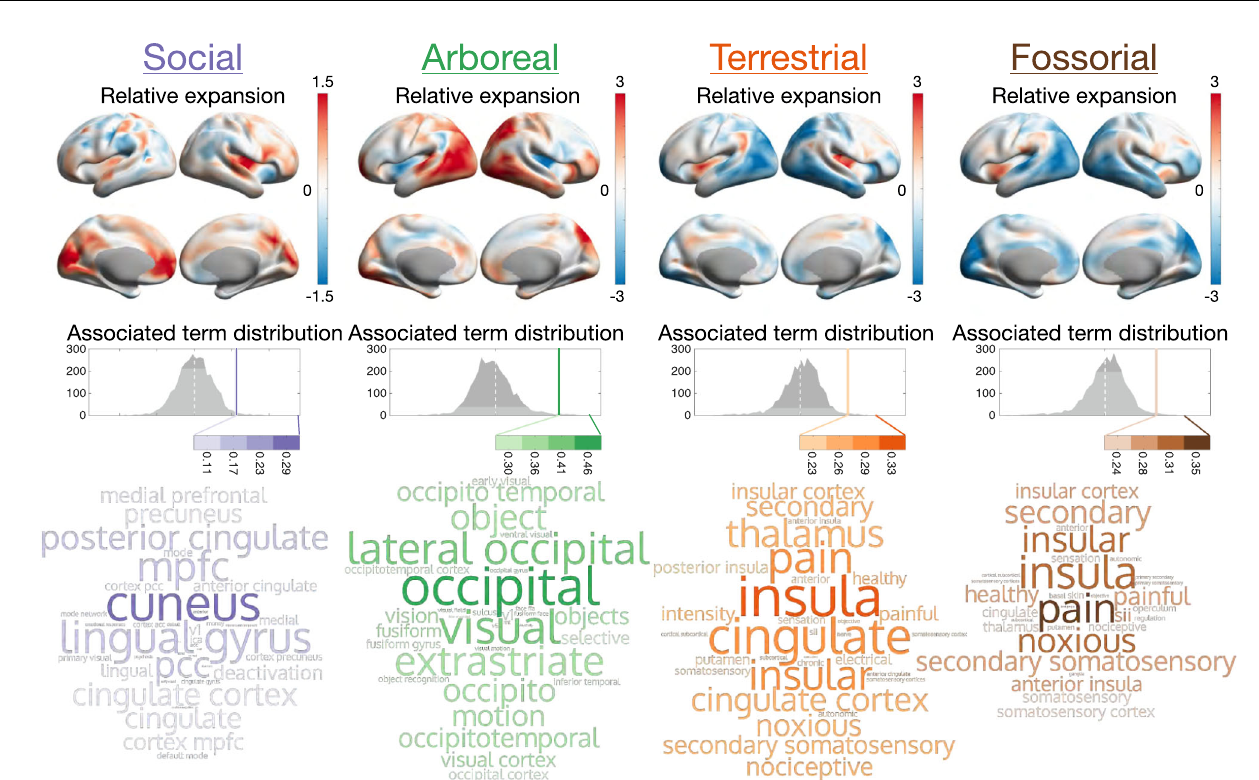
densecorrespondencebetweenthecorticesofthetwospecies;( c )theshapeofthe common ancestors is reconstructed based on these correspondences by inter- polatinginthespaceofsmoothshells;( d ) fi nally,corticalfeaturesareestimatedfor the common ancestor, and the reconstruction is iterated until the root of the phylogenetic tree is reached.